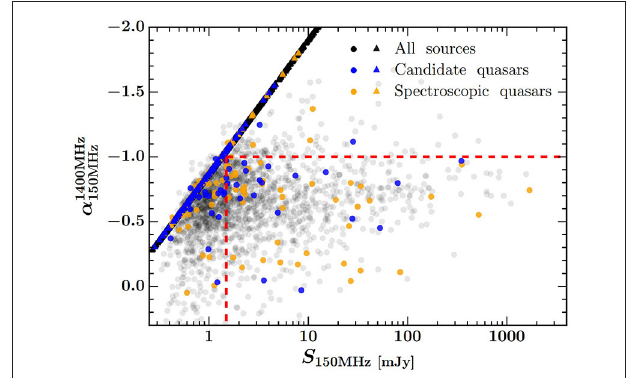
FIGURE 5 | The spectral index between 1,400 and 150 MHz for sources in the Boötes field as a function of the 150MHz flux density. The candidate quasars, spectroscopic quasars, and all the sources in LOFAR catalog are shown by blue, orange and black markers, respectively. The circles denote 5 σ detections in the LOFAR and WSRT catalogs, while the triangles indicate upper limits on the spectral indexes assuming a 5 σ WSRT detection ( S 1.4 GHz = 0.140 mJy) for these objects. The red dashed lines indicate the region with S 150 MHz > 1.5 mJy and α > −